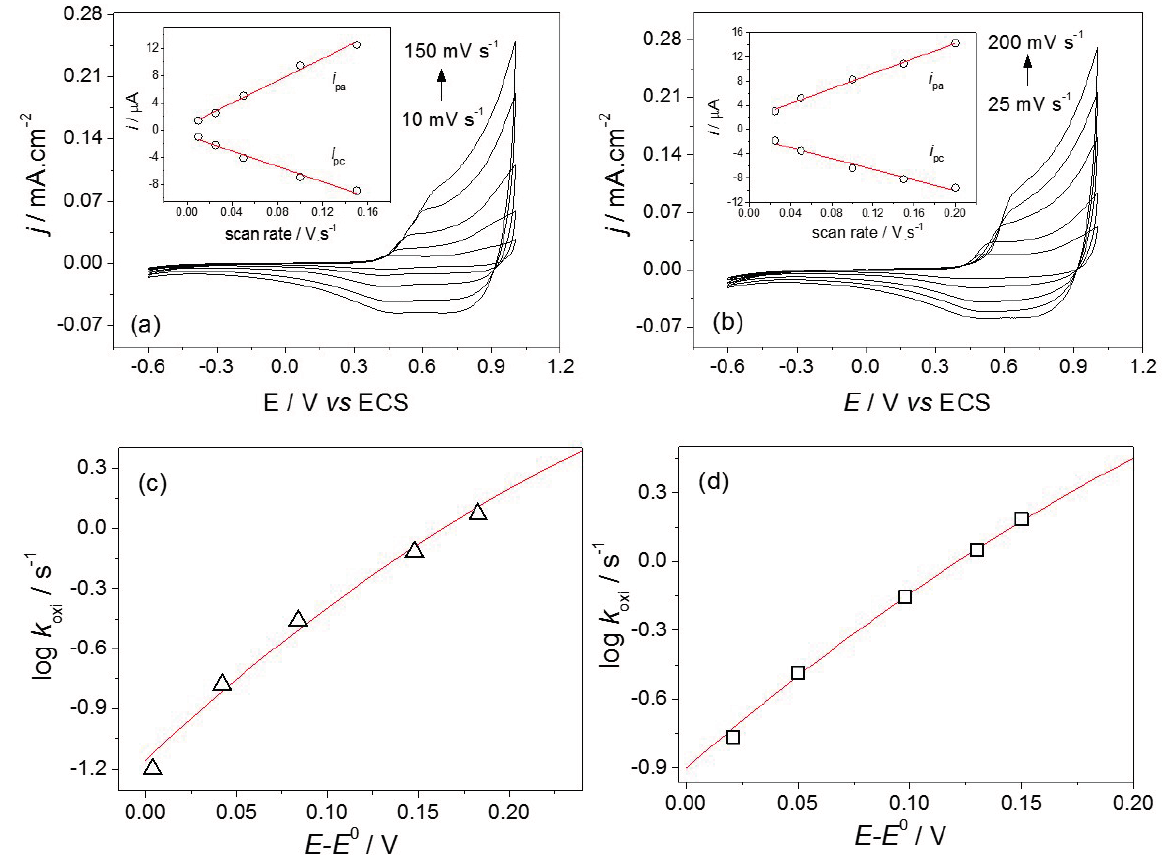
Figure 5. Cyclic voltammograms for ( a ) PBA and ( b ) PBA-CD in 0.1 mol·L − 1 NaCl recorded at different scan rates. Inset : the dependence of the anodic ( i pa ) and cathodic ( i pc ) current peaks as a function of scan rate; Tafel plots of log k oxi vs . overpotential ( E – E °) for ( c ) PBA and ( d ) PBA-CD. The solid lines are the fits to Marcus theory, with λ = 0.5 eV for both systems. The anodic intercept (at E = E °) is –1.15 ( k ° = 0.07 s − 1 ) for PBA and − 0.9 ( k ° = 0.13 s − 1 ) for